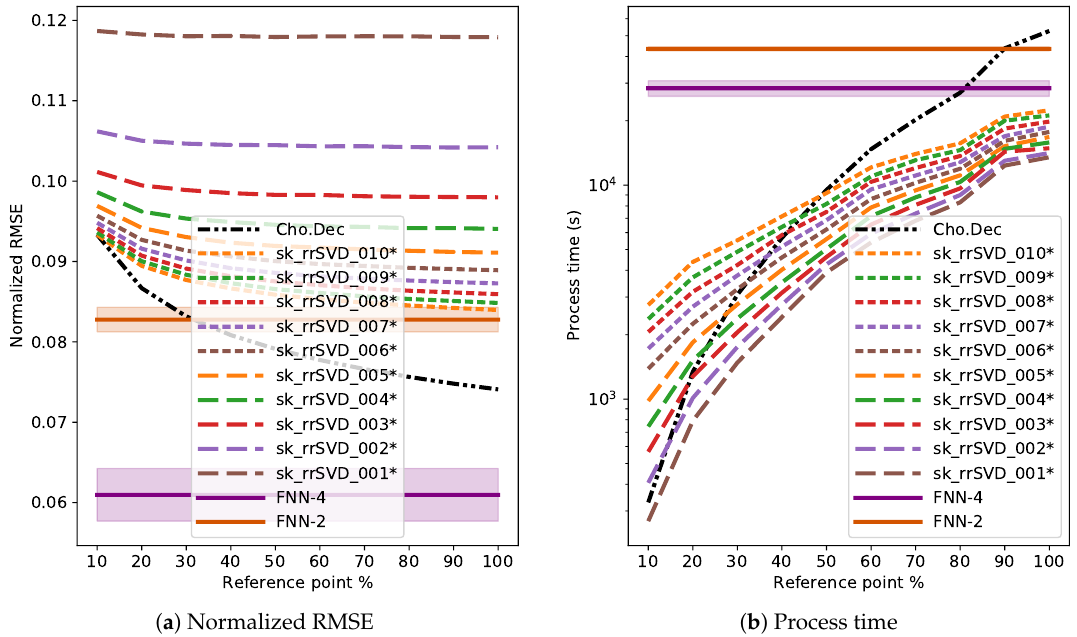
Figure A6. Normalized RMSE values ( a ) and process time in seconds taken to compute Equation (1) ( b ) as a function of reference point percentage for the Mnist dataset. For MLM, variants of sk_rrSVD_XX that differ statistically from Cholesky decomposition are marked with